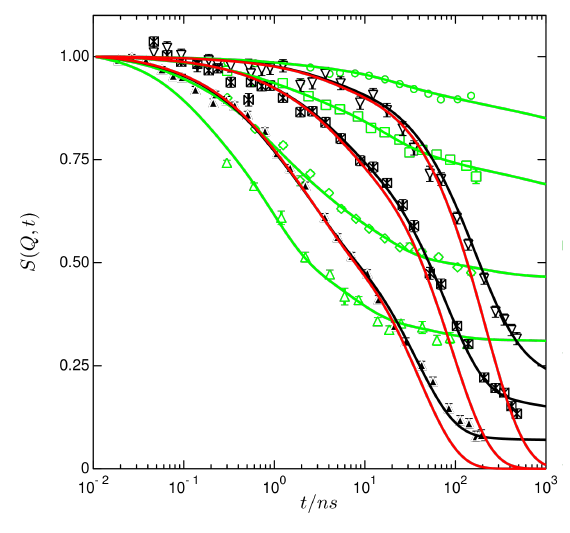
Figure 5. Fits of the scattering function of labelled small PE- tracer molecules (black) consisting of an initial sub-linear dif- fusion and Rouse dynamics with non-Gaussian e ff ects [12] af- ter including the dynamic RPA influence of the long chain ma- trix (green symbols and lines). The tracer volume fraction was ϕ = 0 . 12, the long chain influence leads to excess residual ampli- tiudes at large Q as the comparison with the computation without RPA-e ff ects ( ϕ → 0, red lines) clearly shows. The Q -values for the tracers are: 0.05, 0.078 and 0.12Å − 1 and for the long chains: 0.05, 0.077, 0.115 and 0.145 Å − 1 .